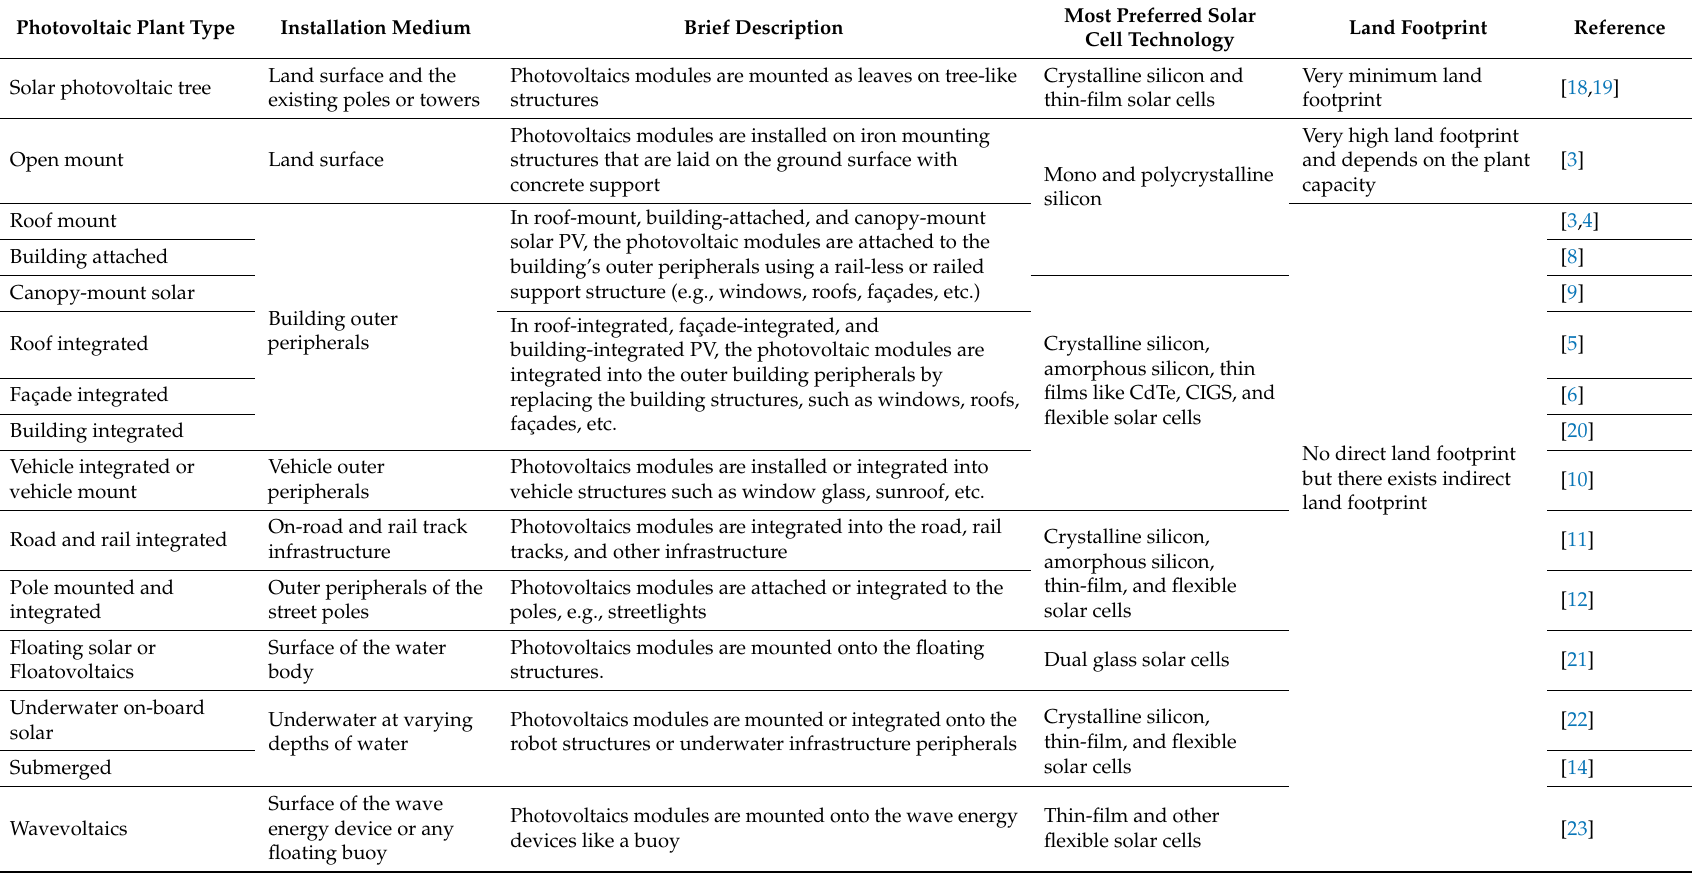
Table 1. Comparing di ff erent types of solar photovoltaic plant types based on the installation considering recent